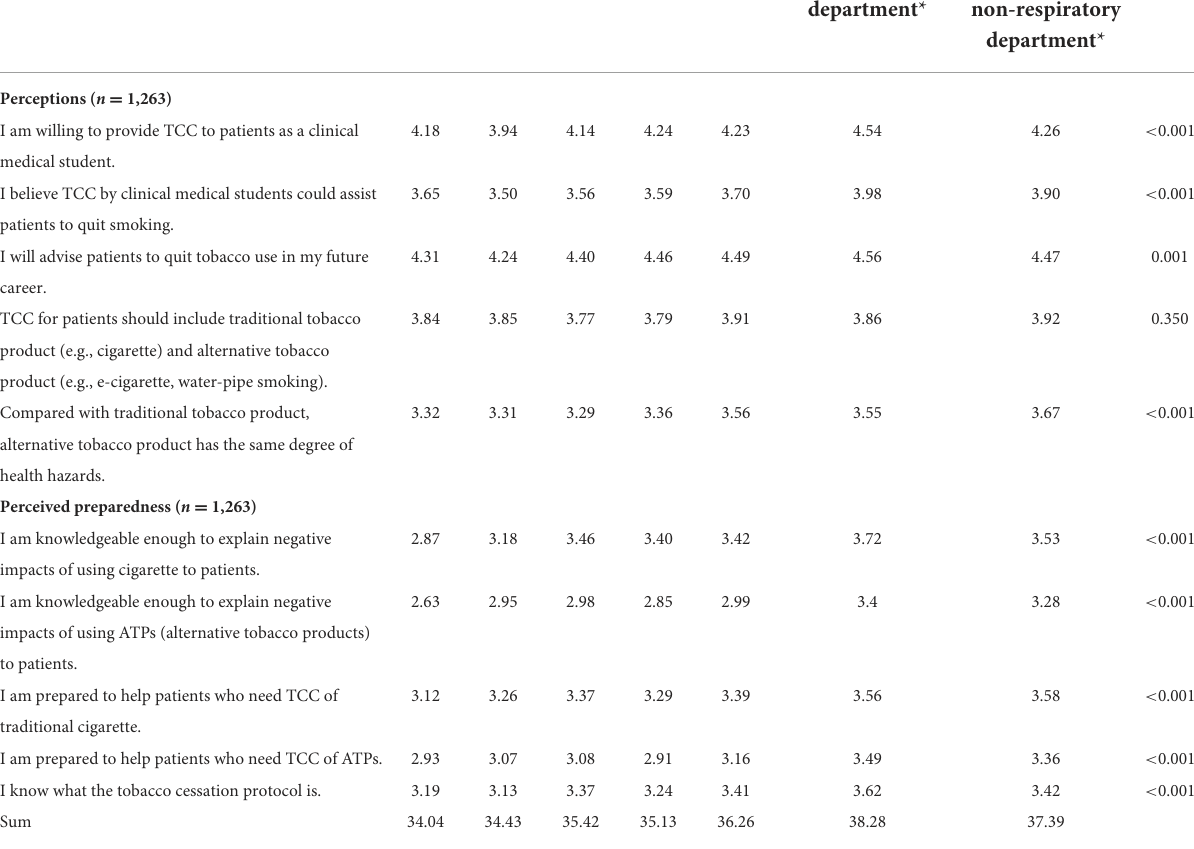
TABLE 3 Variations of clinical medical students’ Perceptions and perceived preparedness toward providing tobacco cessation counseling (TCC).